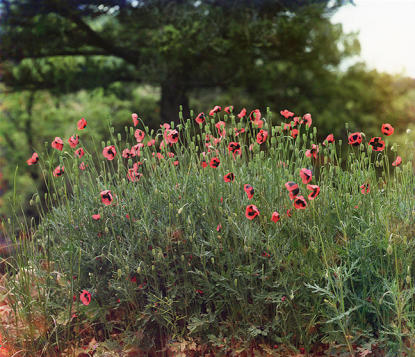
Positive natural selection altered the regulation of the human prodynorphin gene, which produces a product that interacts with the same receptors that opium targets